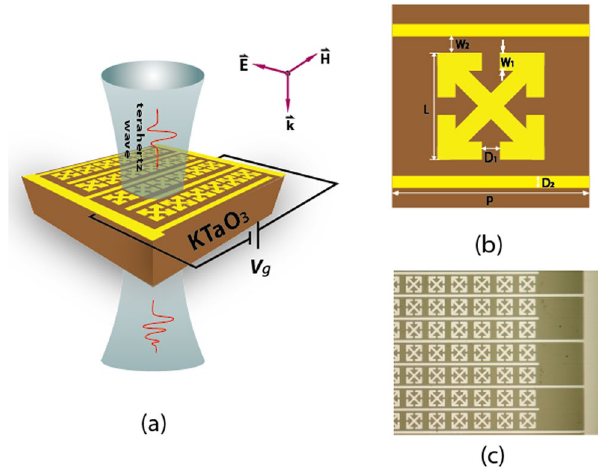
Figure 1. ( a ) Experimental design and illustration of the sample. The KTO crystal was biased with voltage V g . ( b ) Schematic of the unit structure with parameters: P = 50 μ m, L = 35 μ m, W 1 = D 1 = 4 μ m, W 2 = 2.5 μ m, D